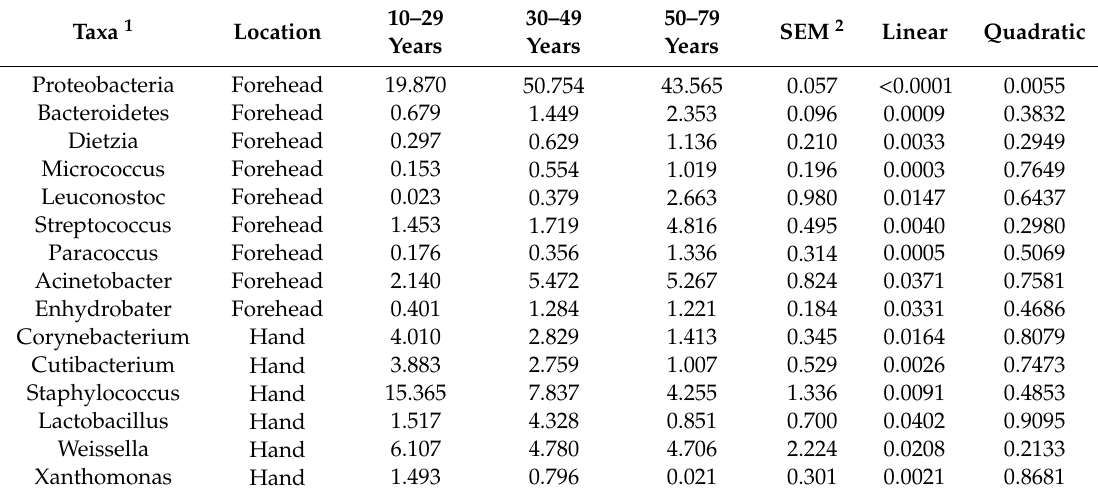
Table 2. Linearly a ff ected major classified taxa by age